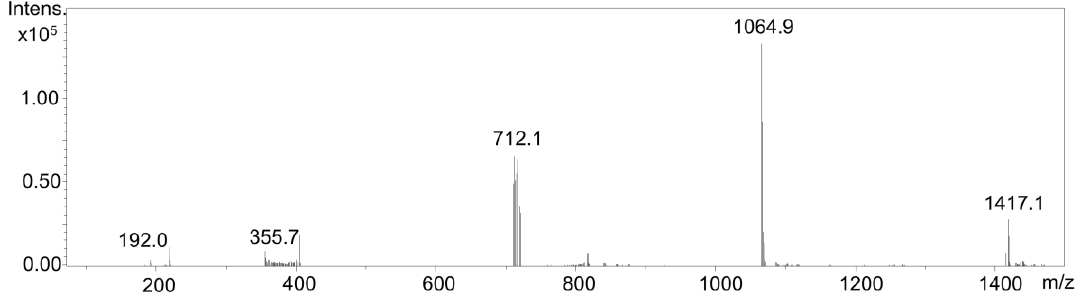
Figure 2. Full scan mass spectra at a retention time 13.5 min of oxidized chlorogenic acid.